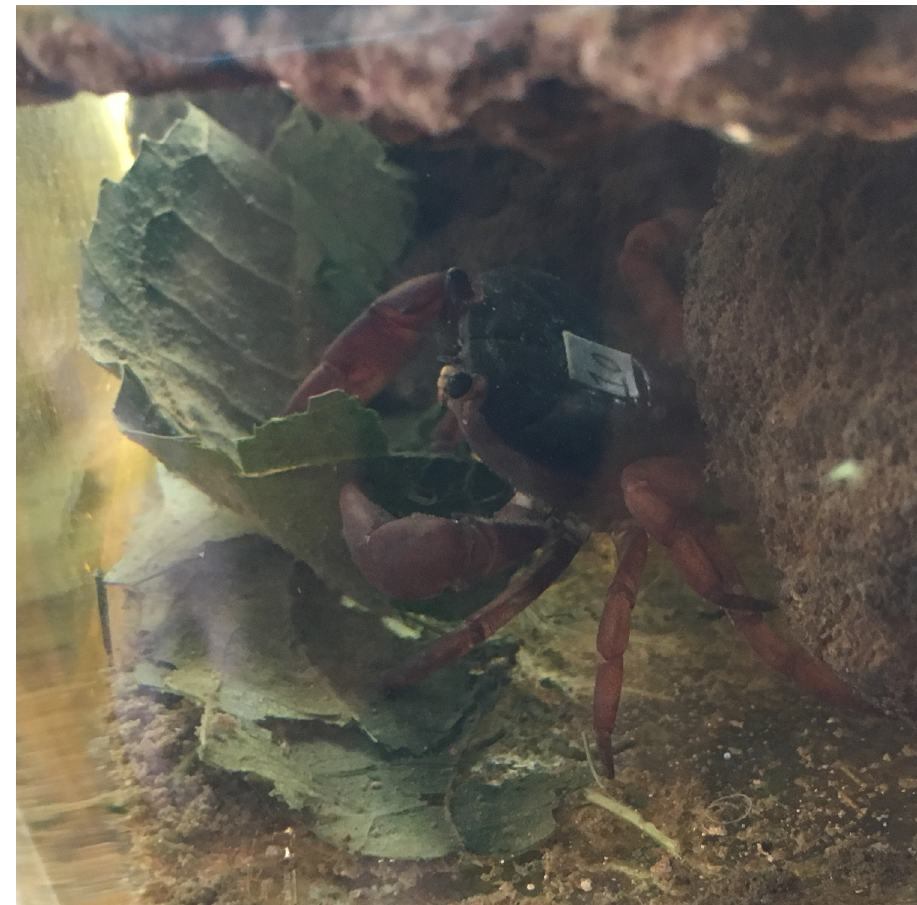
Figure 2. Pseudothelphusid crab ( Ptychophallus tumimanus ) consuming leaf material in a